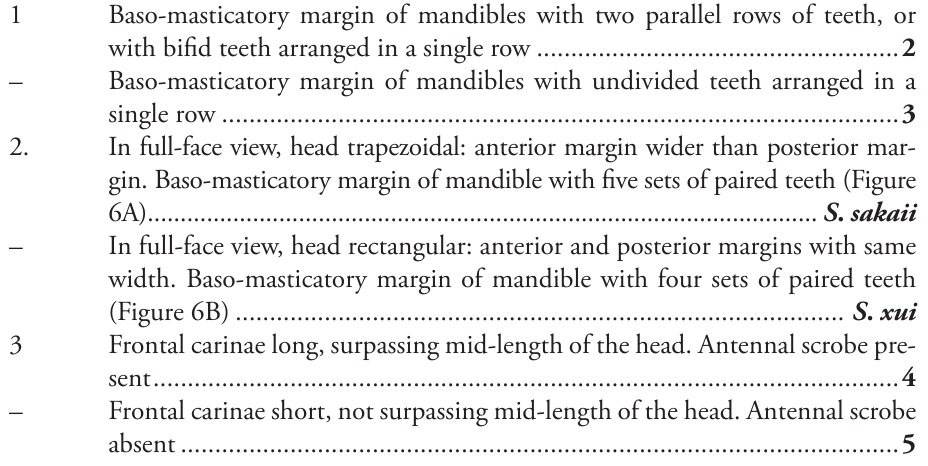
Identification key to the females of the Asian Stigmatomma species with 11 anten- nomeres This key is modified from the identification keys provided by Bharti and Rilta (2015), Eguchi et al. (2015), and Xu and Chu (2012). 1 Baso-masticatory margin of mandibles with two parallel rows of teeth, or with bifid teeth arranged in a single row ..................................................... 2 – Baso-masticatory margin of mandibles with undivided teeth arranged in a single row ................................................................................................... 3 2. In full-face view, head trapezoidal: anterior margin wider than posterior mar- gin. Baso-masticatory margin of mandible with five sets of paired teeth (Figure 6A) ...................................................................................................... S . sakaii – In full-face view, head rectangular: anterior and posterior margins with same width. Baso-masticatory margin of mandible with four sets of paired teeth (Figure 6B) ......................................................................................... S . xui 3 Frontal carinae long, surpassing mid-length of the head. Antennal scrobe pre- sent ............................................................................................................. 4 – Frontal carinae short, not surpassing mid-length of the head. Antennal scrobe absent .........................................................................................................